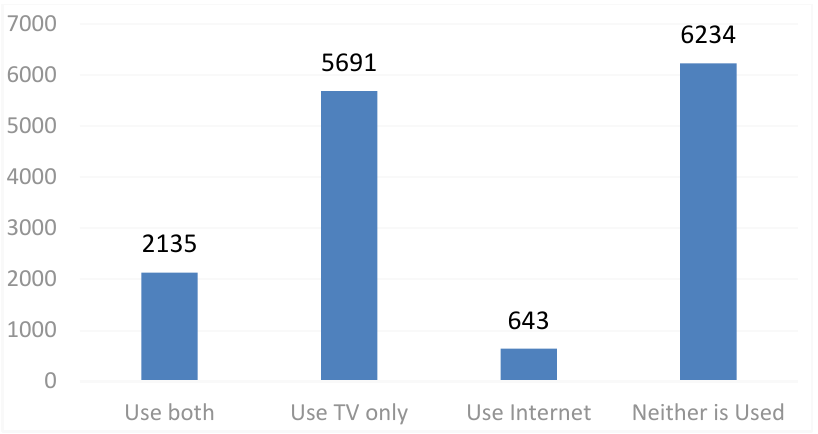
Figure 1. Rural residents’ use of TV and Internet.